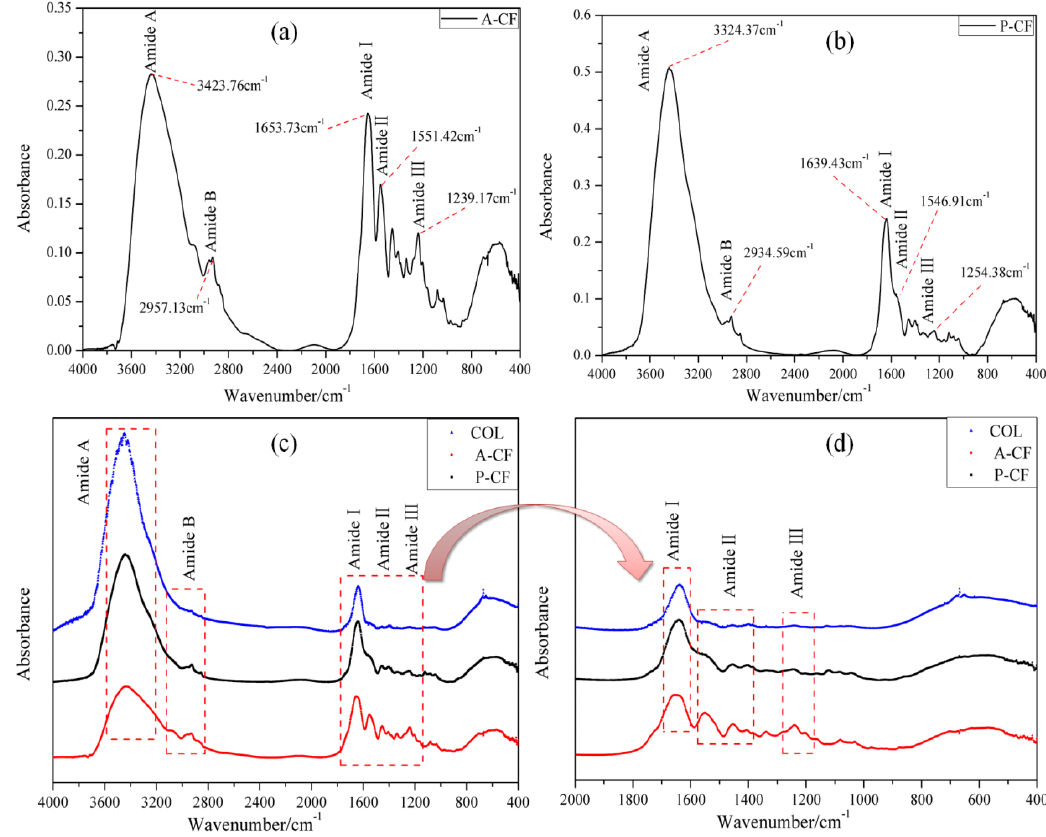
Figure 2. FT-IR spectra of A-CF, P-CF and COL. ( a ) A-CF; ( b ) P-CF; ( c ) COL, A-CF and P-CF (4000–400 cm −1 ); and ( d ) COL, A-CF and P-CF (2000–400 cm −1 ).